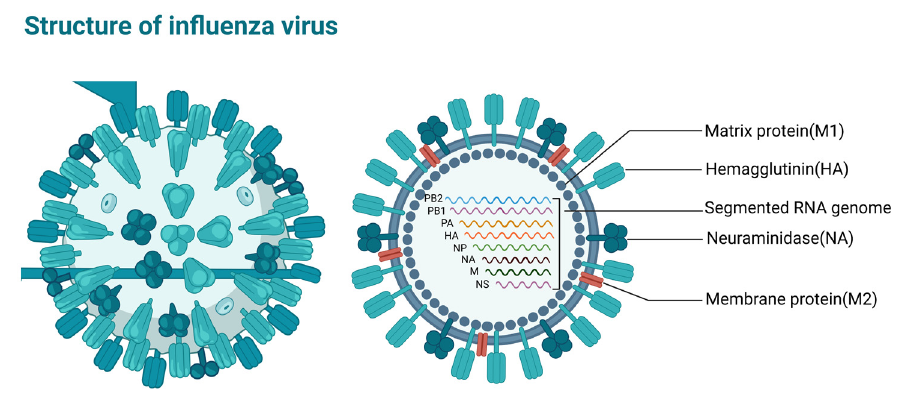
Figure 3. Structure of influenza virus. Image created with BioRender (https://biorender.com/ (accessed on 27 November 2022)).